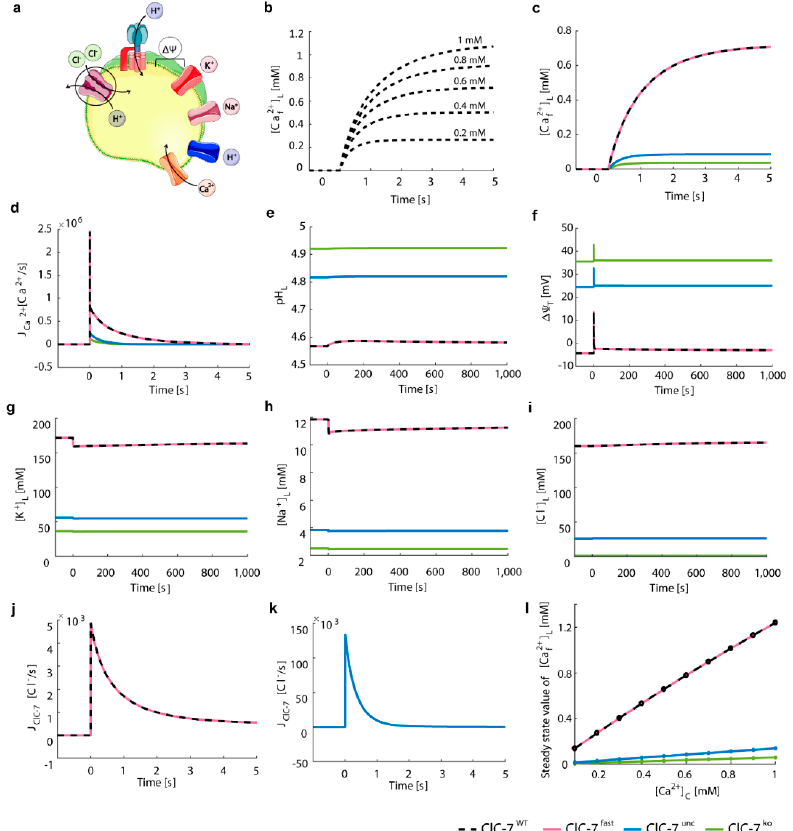
Figure 6. Cl-/H+ exchange supports channel-mediated lysosomal Ca 2+ uptake independent of ClC-7 activation kinetics. ( a ) Schematic representation of the model with ClC-7 antiporters, V-ATPases, potassium, sodium, Ca 2+ channels, and proton leak. The cartoon was created using Servier Medical Art templates (https://smart.servier.com), licensed under a Creative Commons License (https://creativecommons.org/licenses/by/3.0/). ( b – i ) The initial conditions were set to the steady-state values of Figure 4 (Table S3) and from t = 0 s, the lysosomal membrane was permeable to calcium ions (P Ca2+ = 5.7 × 10 − 4 cm/s) representing the opening of the uptake channel. ( b ) Luminal free Ca 2+ concentration of ClC-7WT for five different values of cytosolic Ca 2+ concentration ([Ca 2+ ] C ). ( c - k ) Depicted for the different ClC-7 scenarios during triggered Ca 2+ uptake with a cytosolic Ca 2+ concentration ([Ca 2+ ] C ) of 0.6 mM (ClC-7 WT , dashed black line; ClC-7 fast , red; ClC-7 unc , blue; ClC-7 ko , green) are ( c ) luminal free Ca 2+ concentration, ( d ) Ca 2+ flux, ( e ) luminal pH, ( f ) total membrane potential, luminal concentrations of ( g ) potassium, ( h ) sodium and ( i ) chloride ions, as well as the turnover rates of ( j ) ClC-7 WT and ClC-7 fast , and ( k ) ClC-7 unc. . From t = 0 s, the lysosomal membrane was permeable to calcium ions (P Ca2+ = 5.7 × 10 − 4 cm/s) representing the opening of the uptake channel. ( l ) Steady state value of luminal free Ca 2+ concentration for 10 different [Ca 2+ ] c values for the different ClC-7 scenarios.